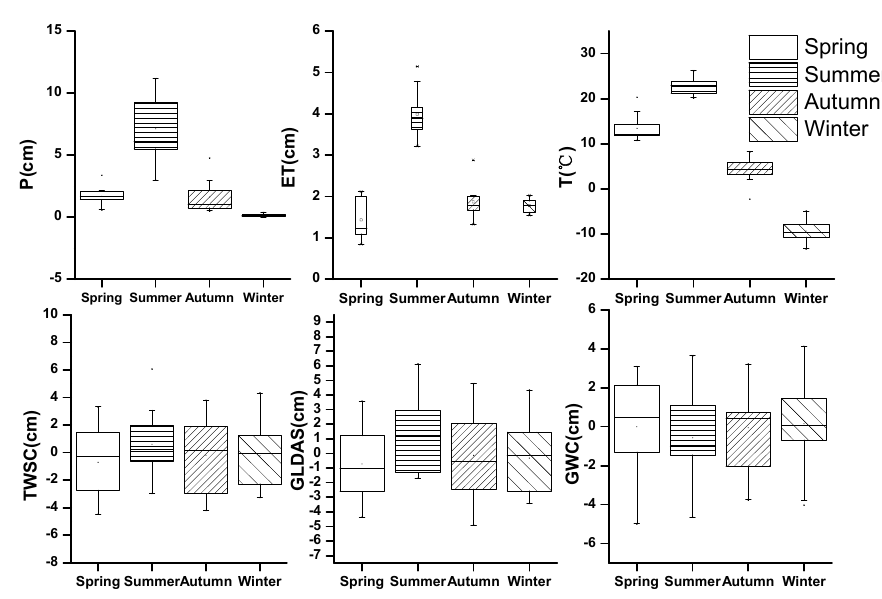
Figure 3. Seasonal P, T, ET, TWSC, GLDAS (SWEC&SMC&TCWSC) and GWC from 2002–2014.